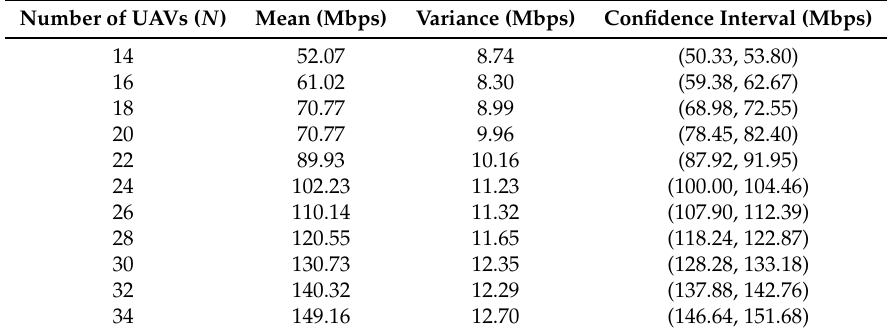
Table 1. Statistical analysis considering amount of UAVs ( L = 10, Od = 0.4, Borderlength = 200 m).